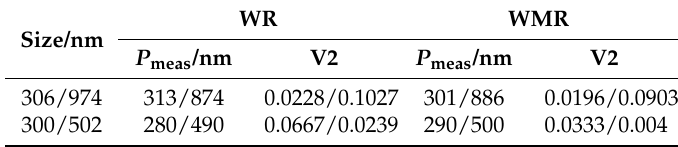
Figure 4. The inversion results with WR and WMR method from experimental DLS data: ( a ) 306/974 nm bimodal particles; ( b ) 300/502 nm bimodal particles. Table 5. The performance indices of the inversion for experimental DLS data.